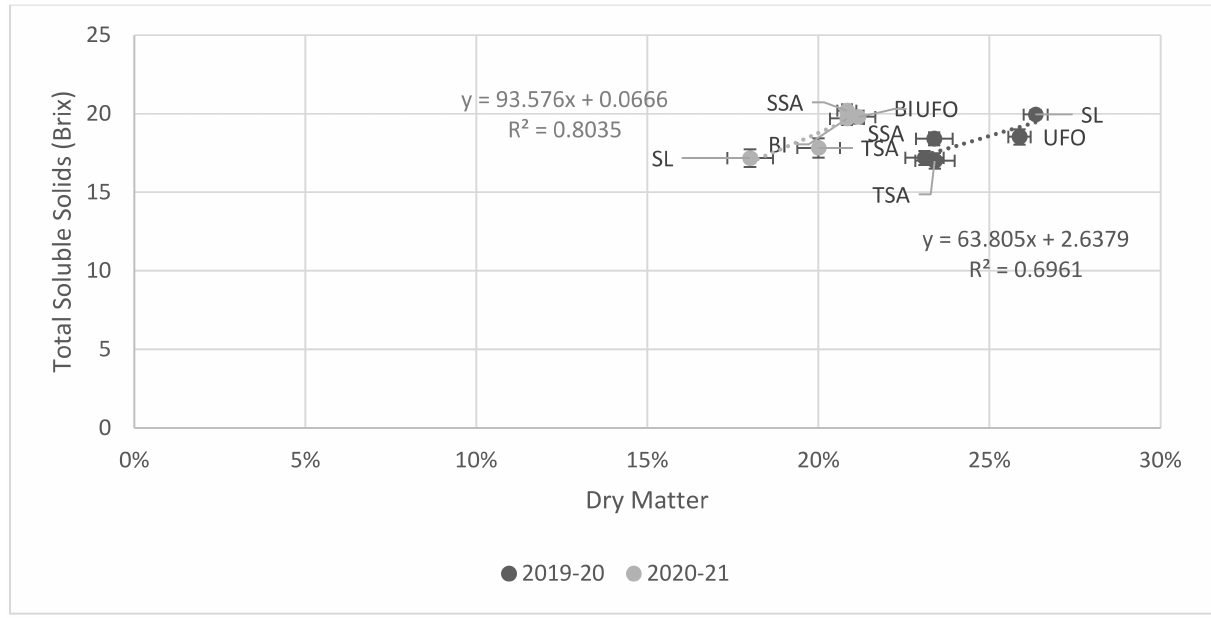
Figure 6. Association between fruit TSS and DMC of sweet cherry cultivar ‘Kordia’ across different training systems and seasons. Error bars represent one standard error for each training system and n = 6 for each system in a